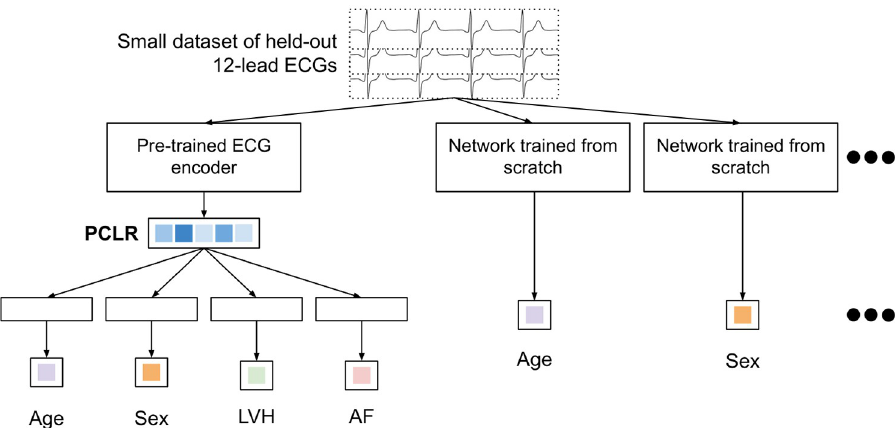
Fig 6. Flowchart comparing training models on PCLR and training models from